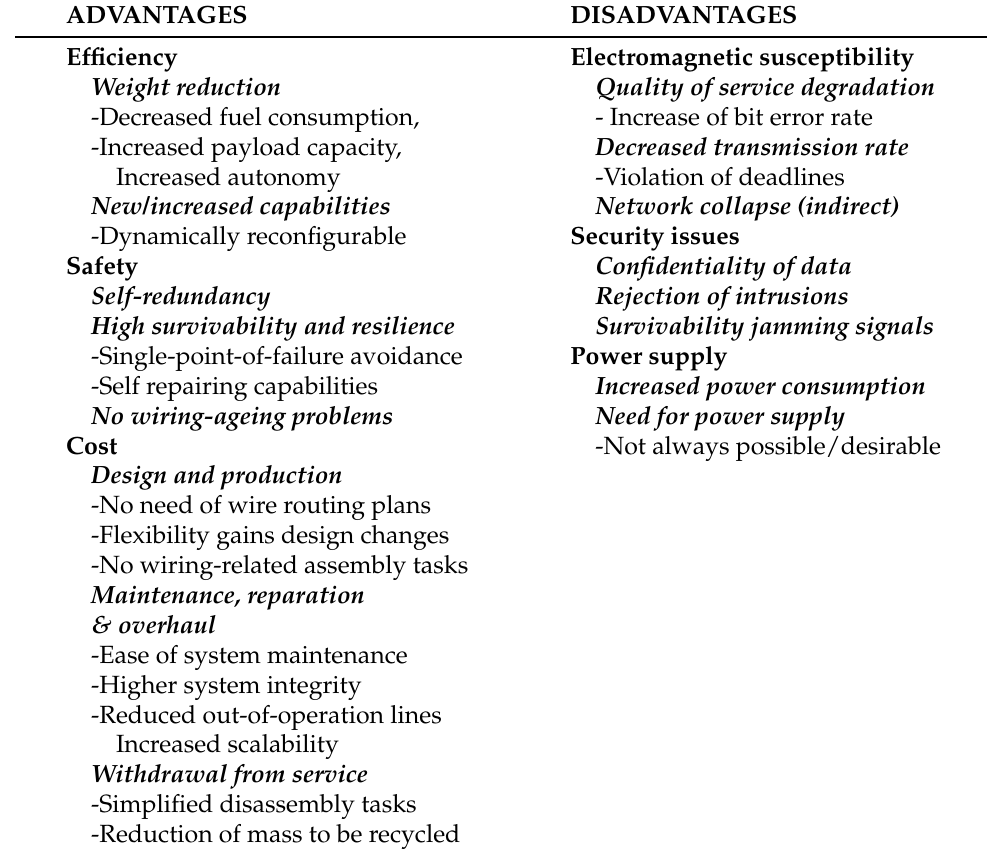
Table 1. Advantages vs. disadvantages of wireless technologies in industrial applications